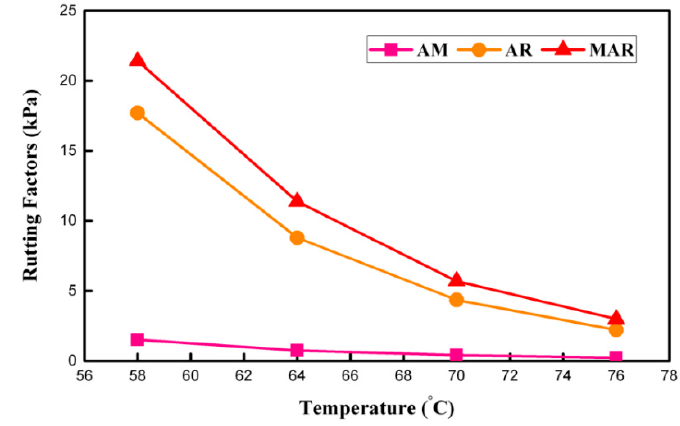
Figure 2. G * / sin ( δ ) of AM, AR, and Figure 2. G * /sin ( δ ) of AM, AR, and MAR.